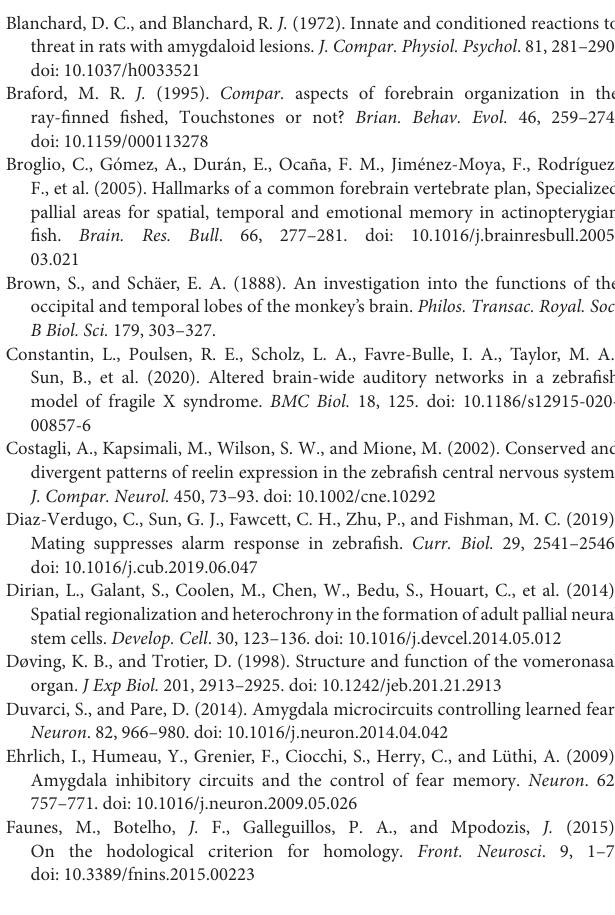
FIGURE 2 | 120A-Dm-neurons. (C1) Dorsal view. Scale bar, 500 µ m. (C1’) Coronal view as above. Scale bar, 200 µ m. (D) Gal4FF drivers lines are crossed with botulinum toxin effector fish (UAS:zBoTxBLC:GFP). The double transgenic fish is analyzed in an active avoidance fear conditioning assay. (E) 120A-Dm-neurons have efferent projections to Vd, Vs, EN, Ppa, and hypothalamus. CCe, corpus cerebelli; Dl, dorsolateral telencephalon; EN, entopeduncular nucleus; OB, olfactory bulb; Ppa, preoptic area; TeO, optic tectum; Vd, the dorsal zone of the ventral telencephalon; Vv, the ventral zone of the ventral telencephalon [figures reused and